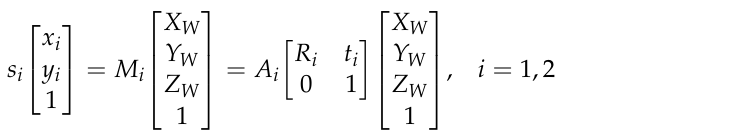
where s i denotes the scale factor, M i represents the projection matrix obtained by the multiplication of intrinsic parameters matrix A i and extrinsic parameters [ R i , t i ] with R i being a 3 × 3 rotation matrix and t i being a 3 × 1 translation vector, respectively. The intrinsic parameters (i.e., principal point coordinates c x , c y , effective focal length f x , f y , skew factor γ , etc.) are the inherent camera properties. Further, the extrinsic parameters indicate the 3D position and orientation of cameras with respect to the word coordinate frame.